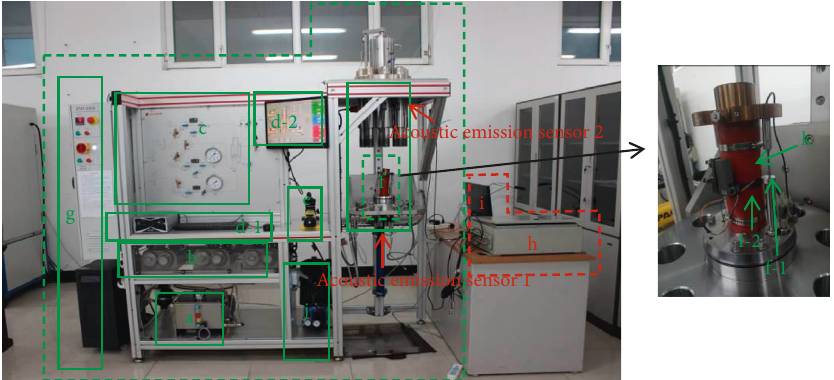
Figure 2: Synchronous unloading mechanical experiment device and acoustic acquisition